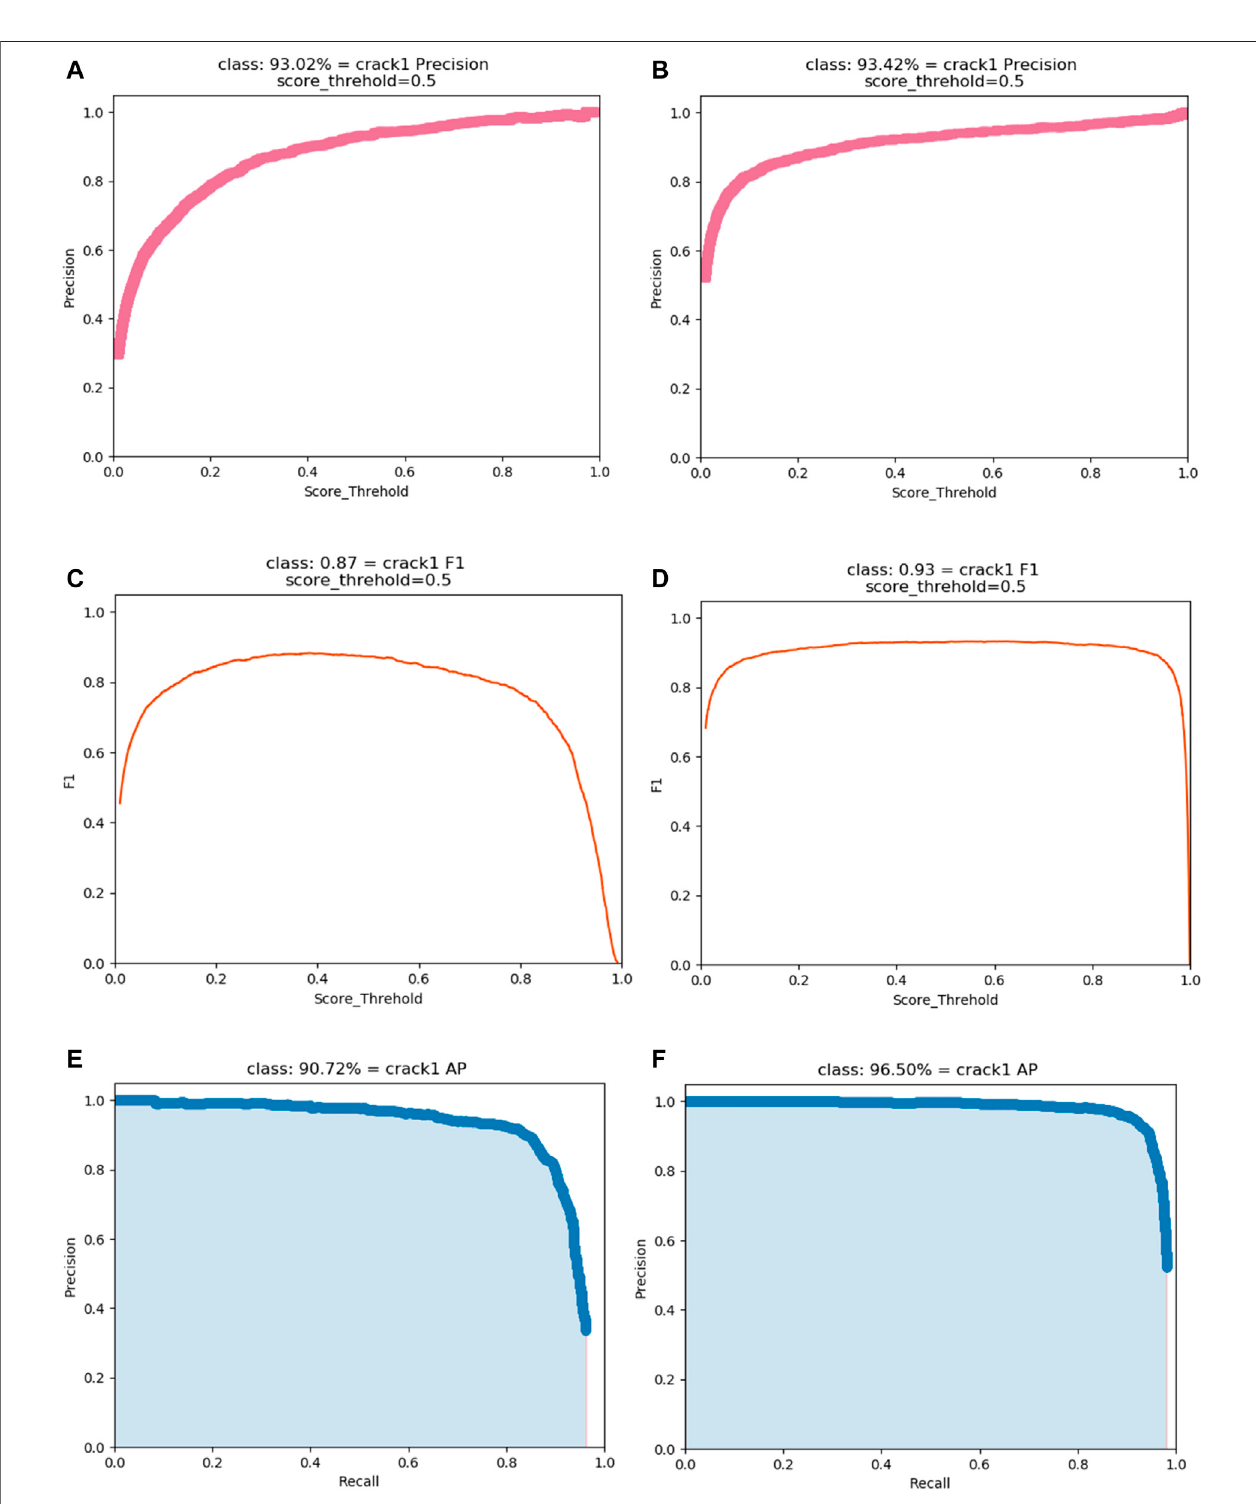
FIGURE 12 | The indices of the lightweight YOLOv4 model and the improved model in fog: (A) Precision of the lightweight YOLOv4 model (B) Precision of the improvedmodelinfog (C) F 1 ofthelightweightYOLOv4model (D) F 1 oftheimprovedmodelinfog (E) APofthelightweightYOLOv4model (F) APoftheimprovedmodel in fog.